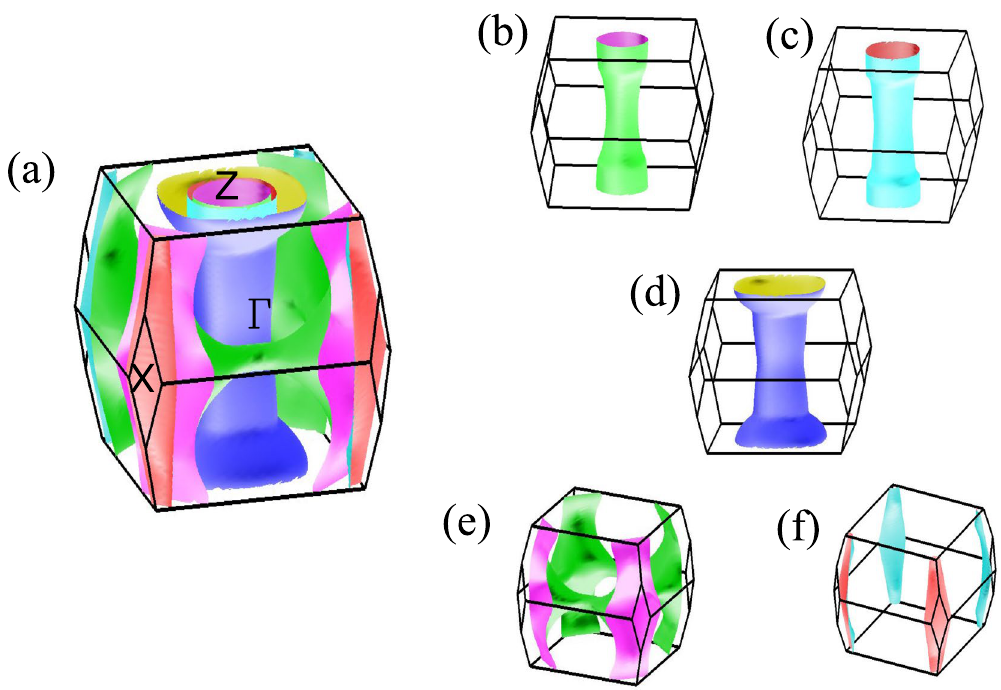
Figure 12. ( a ) Fermi surface in the tetragonal phase with z As fixed to its experimentally observed value of 0.372. ( b – f ) shows the individual Fermi